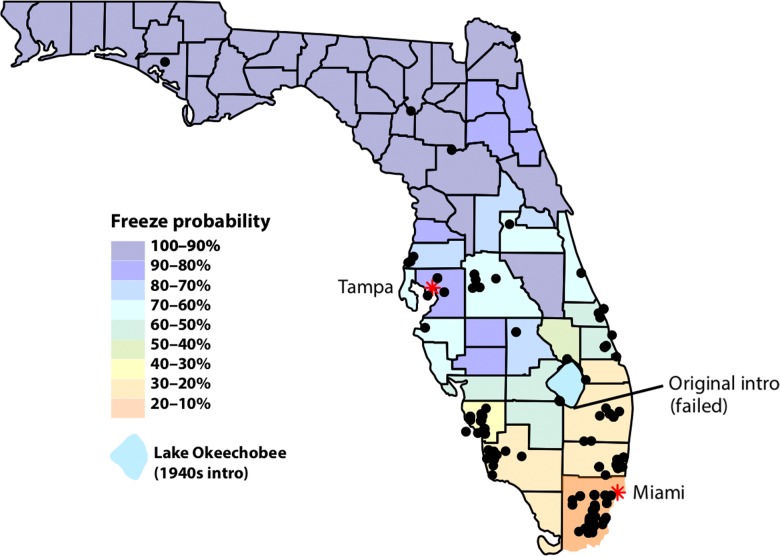
Cane toad sightings since 2010 (black dots, point data from EDDMapS, 2015). Counties are coloured by annual freeze probability (Southeast Climate Consortium, 2017), and red asterisks represent Tampa (Northern population) and Miami (Southern population).